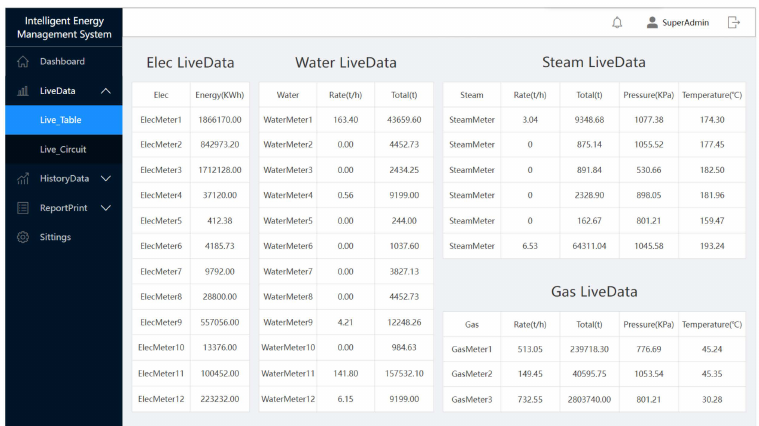
Figure 8. Real-time data